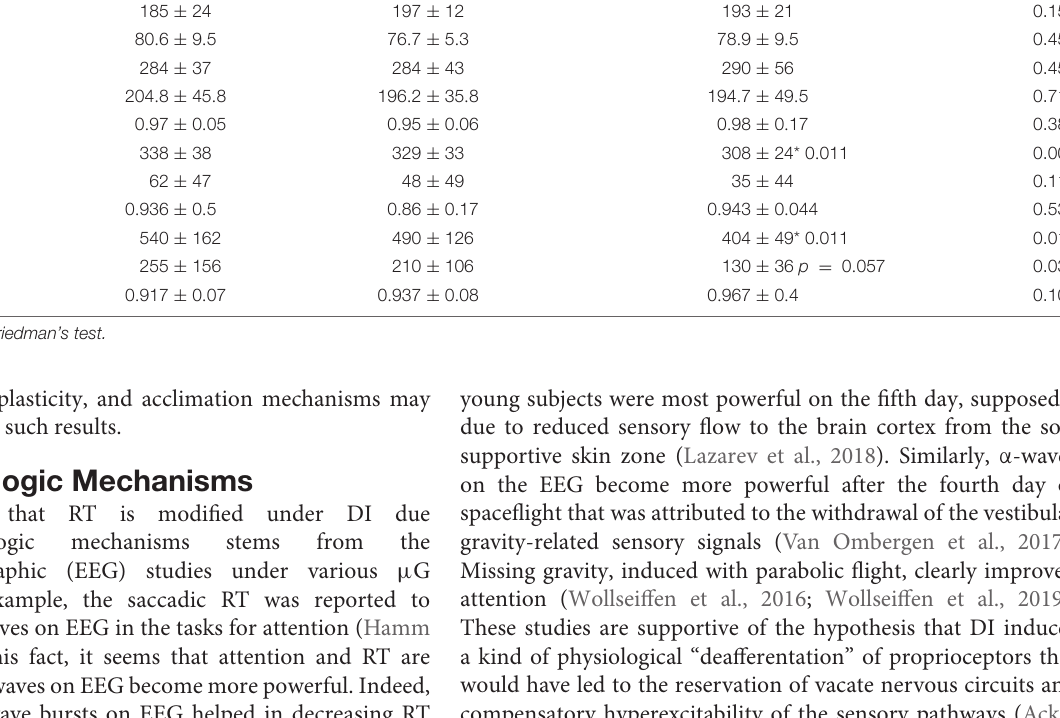
FIGURE 2 | Individual change of the studied RT tasks (delta% of preDI) in the DI group ( n = 10) at the study point “DI2w” (2 weeks after DI) in respect of the background data (point “preDI”), with correlation coefficients and approximation lines. MT, motor time; SRT, simple reaction time; DRT, discriminative reaction time; CRT, choice reaction time. TABLE 3 | Numeral characteristics of the RT tasks across the program of DI and after it in the DI group. Parameters PreDI PostDI DI2w p